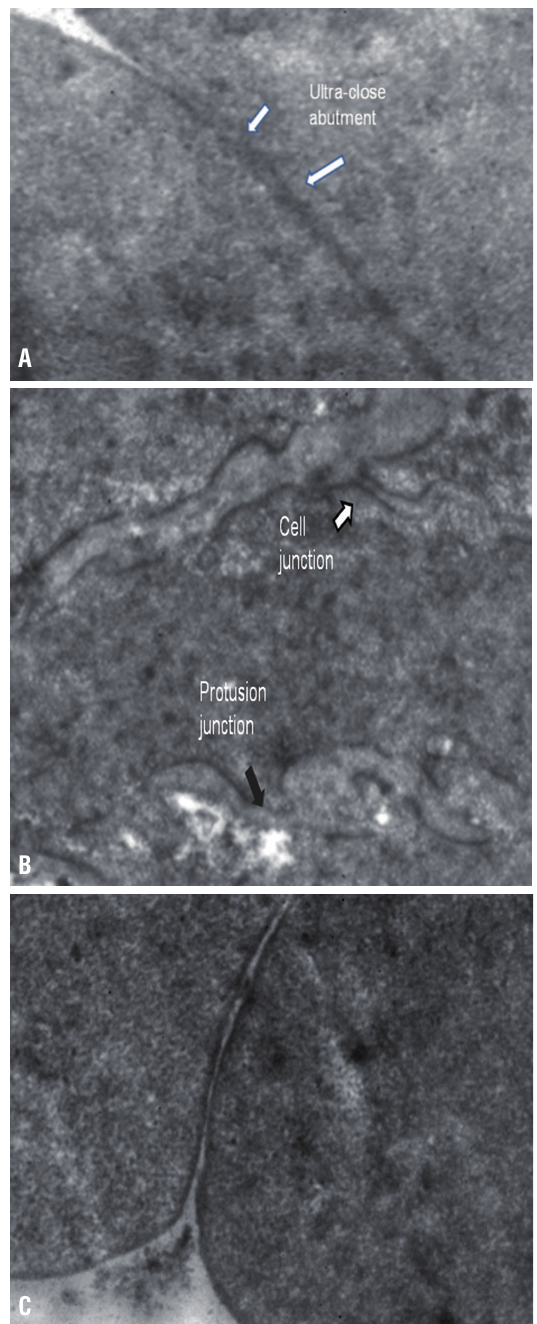
Figure 1 - a) Variant of normal Intercellular Junctions (x- 16400); 1b) Myocytes with normal intercellular junction and protrusion junction (X-17000); 1c) Normal Intercellular Junction (X-17600) this consists of two closely apposed 25- 70nm wide gap sarcolemma lying parallel to each other for a length of up to 10μm with paired symmetrical dense